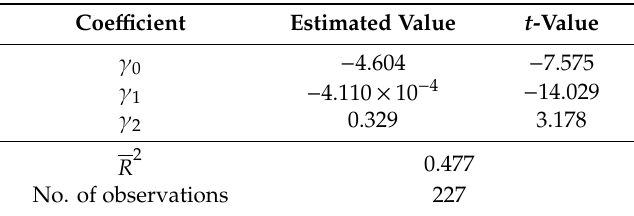
Table A1. Estimated parameters in the utility